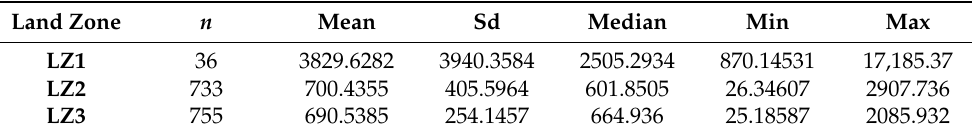
Figure 7. Actual urban land prices per m 2 in USD against distance in kilometers from the economic center and categorized as center or surrounding. The center is within the CBD, while the surrounding is beyond the 5 km radius. Table 1. Descriptive summary of land price per m 2 in USD for the designated land zones.